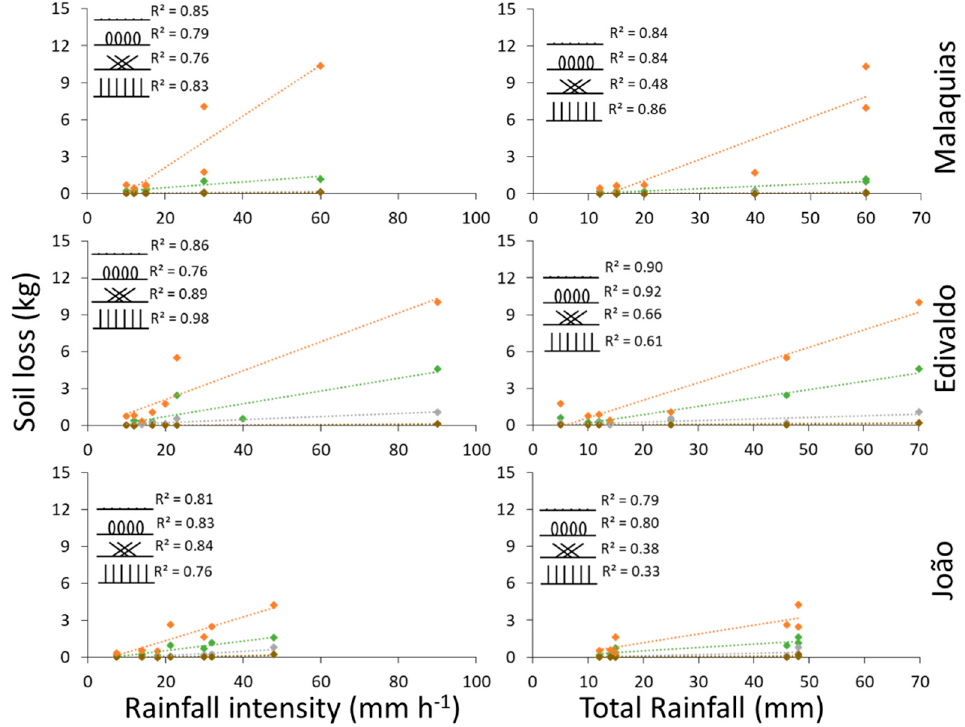
Figure 7. Soil loss as a function of rainfall volume and intensity, for all sites and plots.